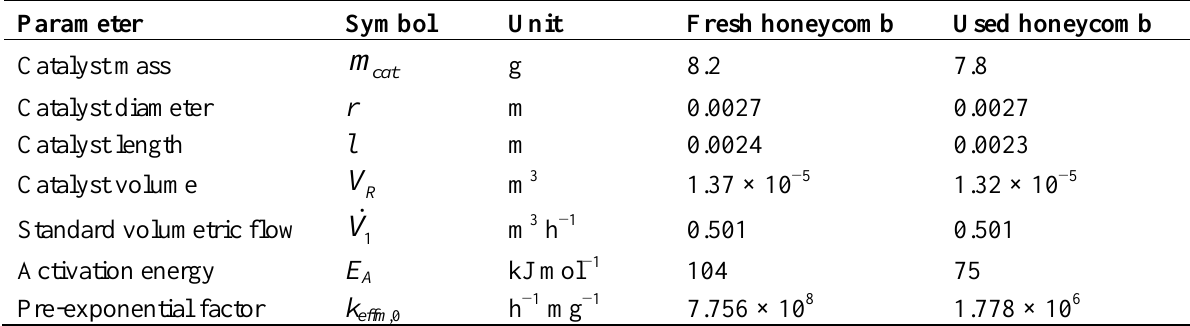
Table 1. Experimental parameters of both